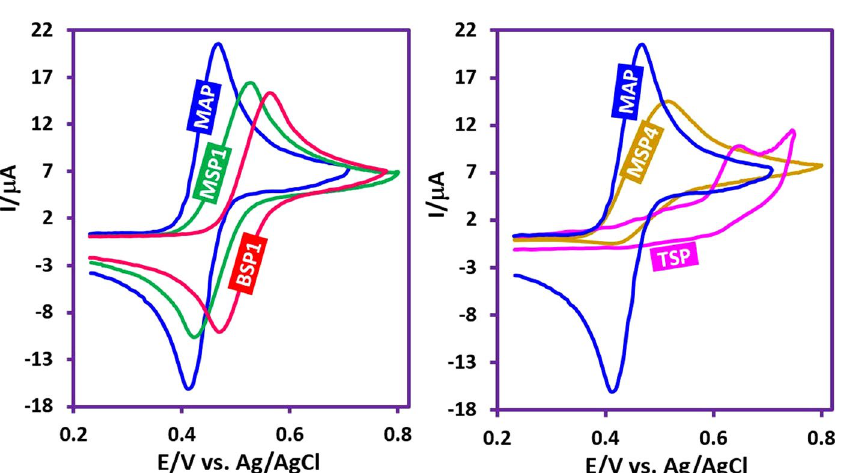
Figure 5. Cyclic voltammograms of: MAP (1.0 mM), MSP1 (0.7 mM), BSP1 (0.5 mM), MSP4 (0.5 mM) and TSP (0.25 mM). Solvent for MAP : aqueous phosphate buffer, c = 0.2 M, pH = 2.0. Solvent for MSP1 , BSP1 , MSP4 and TSP : aqueous phosphate buffer ( c = 0.2 M, pH = 2.0)/ethanol (80/20, v/v). Working electrode: glassy carbon electrode. Scan rate 100 mV s − 1 . Temperature = 25 ± 1